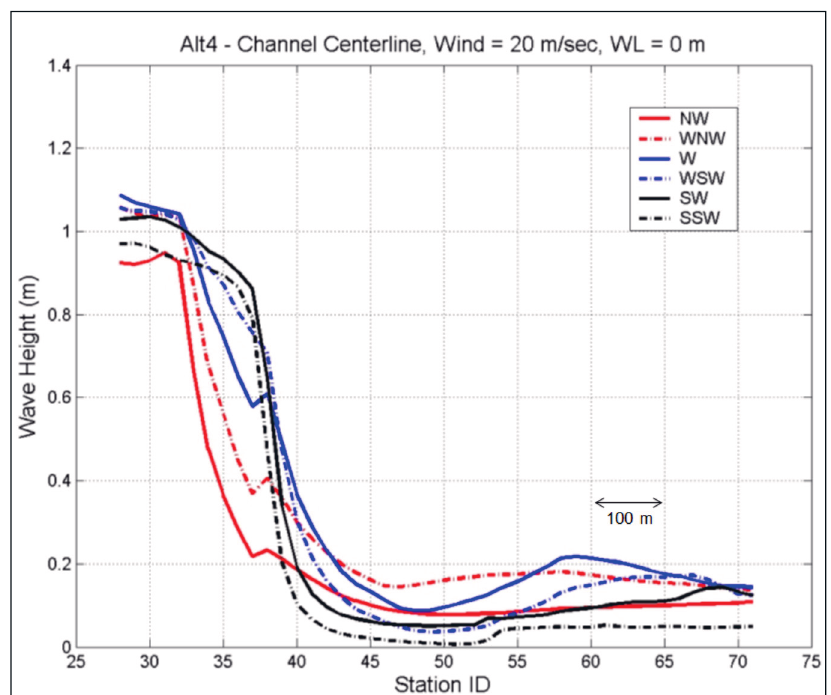
Figure 25. Model wave heights for Alt 4 along the west channel for 50-year design wind from six directions (NW, WNW, W, WSW, SW, and SSW) and WL = 0 m. For example, Figures 26–28 show the wave height reduction factor along the channel centerline for Alternatives 1 to 5 for 50-year design winds from directions of NW,W,SW, respectively, and WL = 0 m.